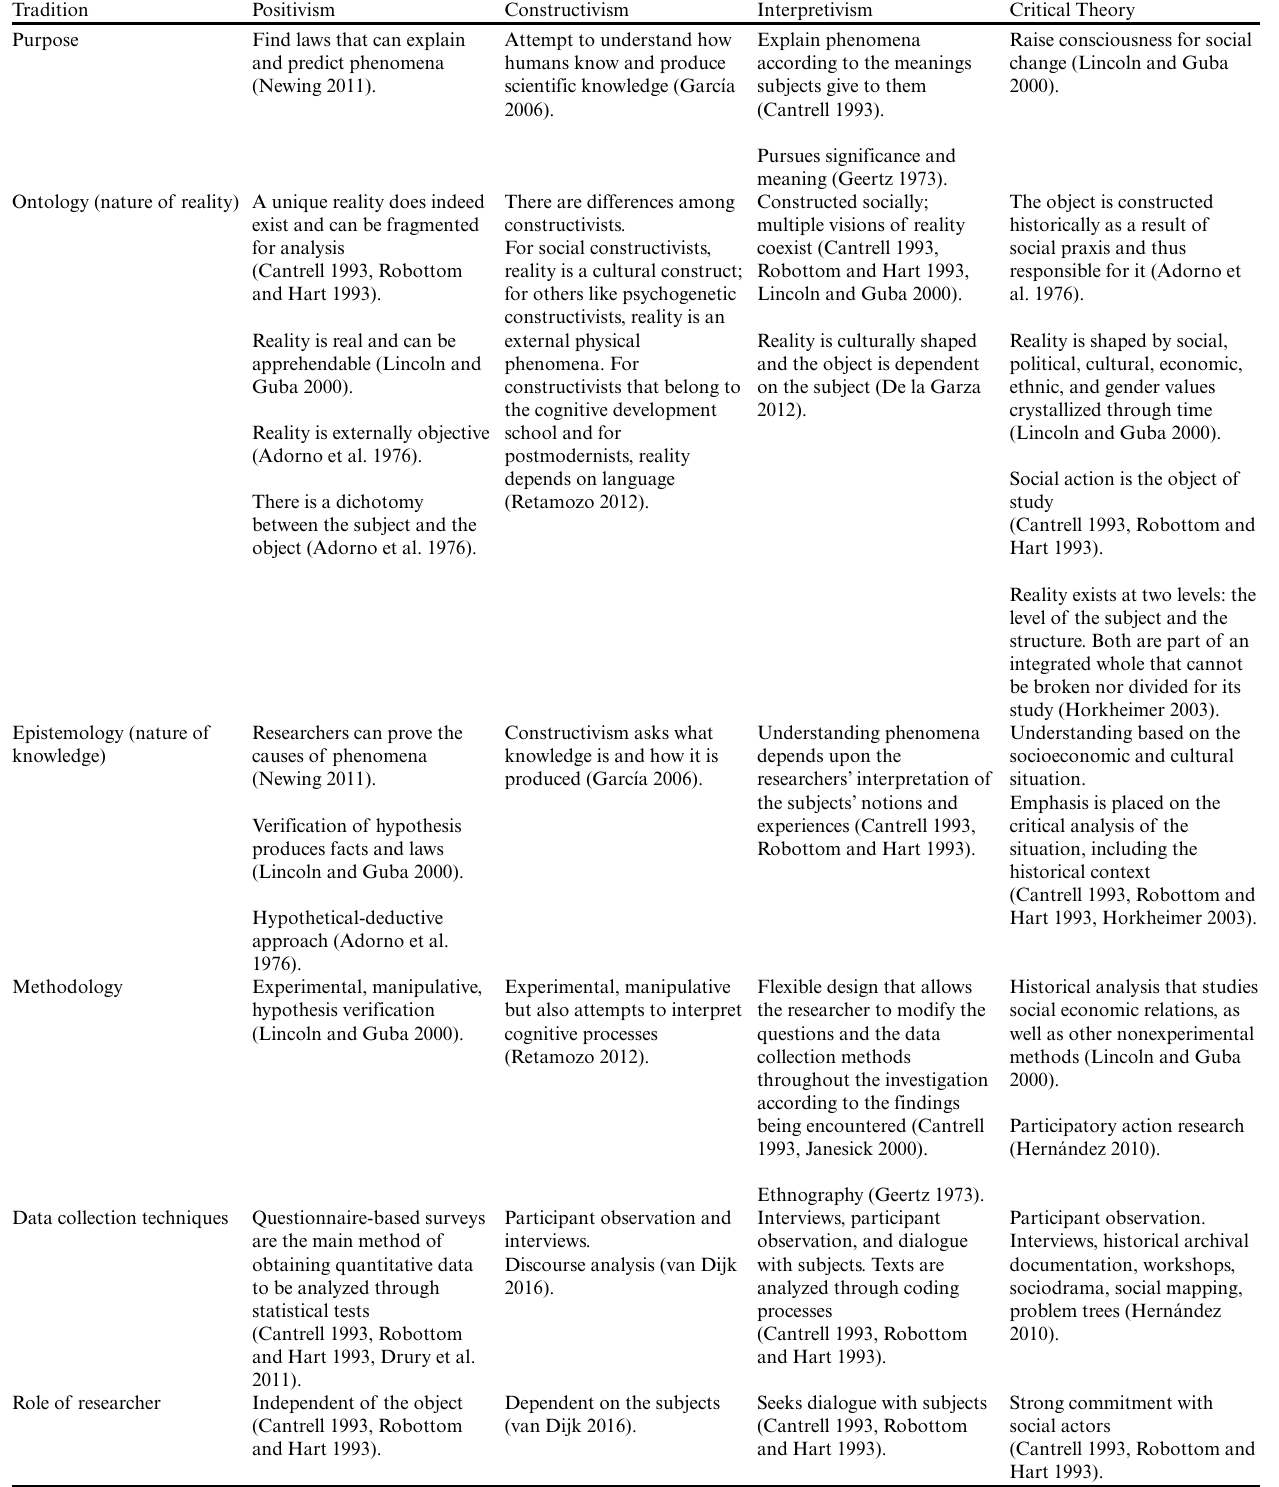
Table 1 . Distinctive characteristics of four research traditions in the social